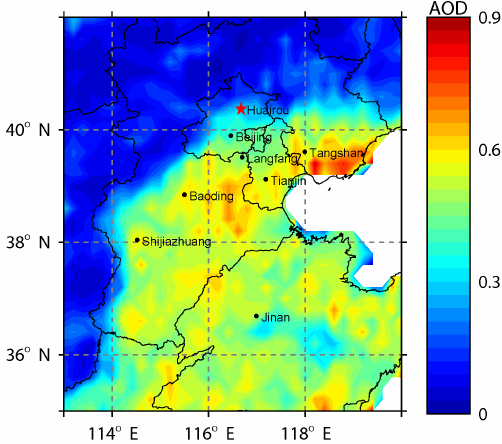
Figure 1. The map of the North China Plain. The observation site (Huairou) is marked with red star. The contour plot represents the average distribution of the MODIS AOD with 0.2 ◦ × 0.2 ◦ resolu- tion during the campaign (16 November 2014 to 11 January 2015).